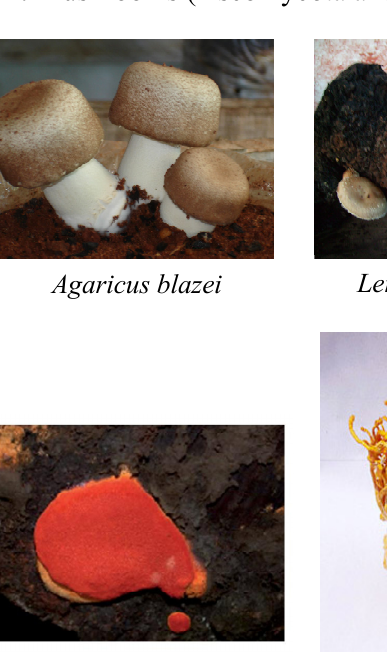
Figure 2. Mushrooms (Ascomycota and Basidiomycota) used in hepatoprotective